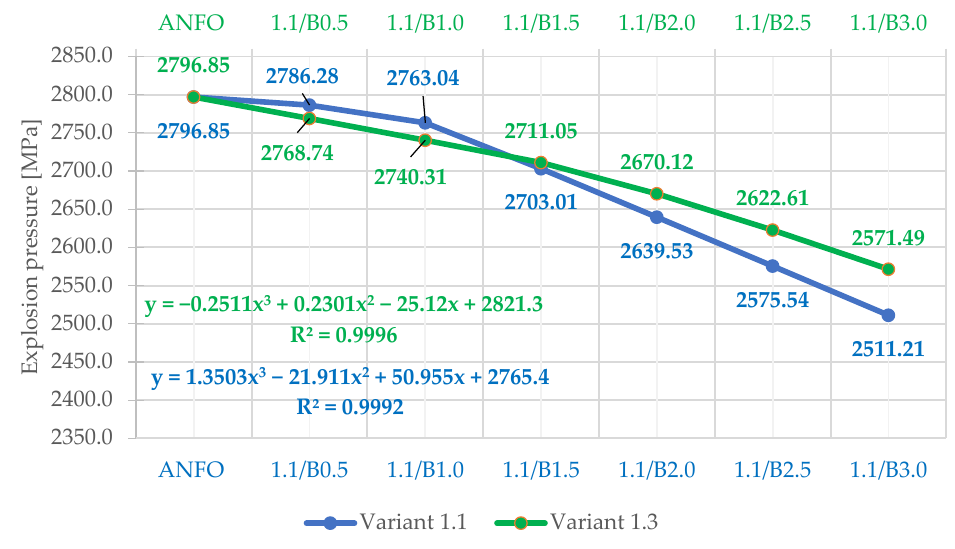
Figure 5. Explosion pressure changes for individual explosives.